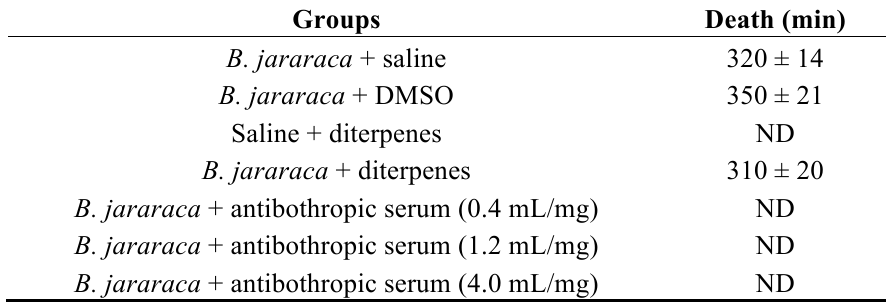
Table 1. Effect of mixture of diterpenes on lethality of B. jararaca venom. B. jararaca venom (30 µ g/g) was incubated for 30 min at room temperature with 60 µ g/g of